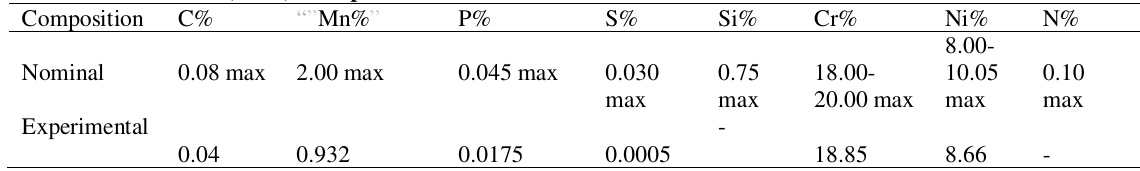
Chemical contents of (304L) workpiece used in this work. ” Composition